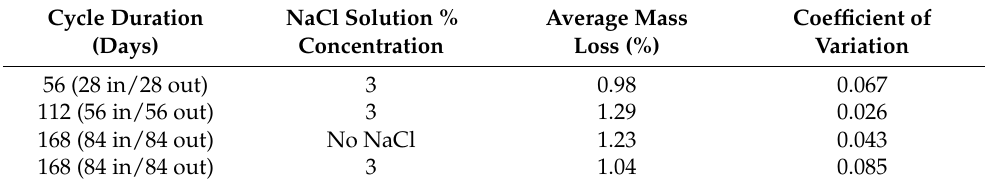
Table 5. Average Mass Loss, Coefficients of Variation per Chloride Corrosion Test Specimen